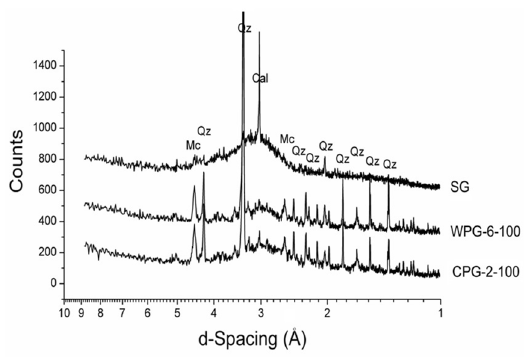
Figure 6. XRD comparing the SG resin with the WPG-6-100 and CPG-2-100 resins. Muscovite (Mc), quartz (Qz) and calcite (Cal) are